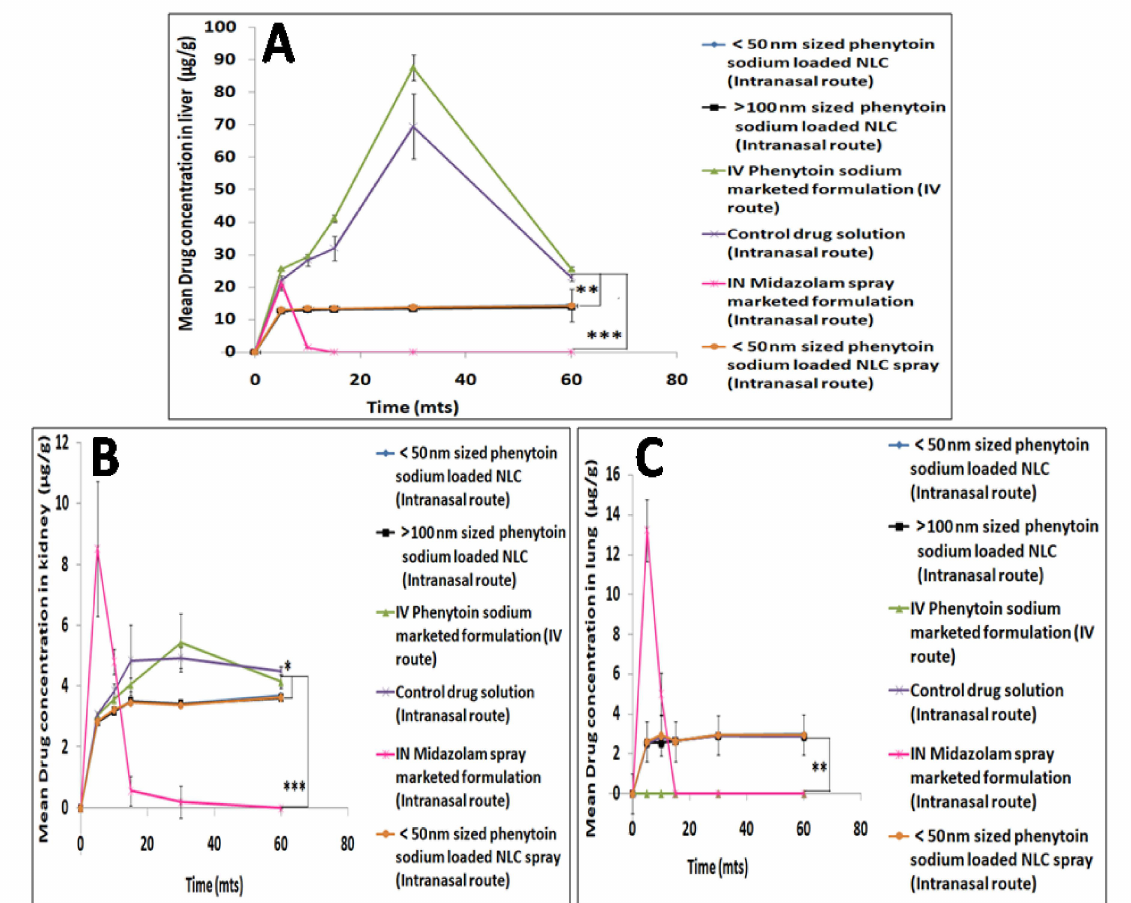
Figure 8. Mean liver ( A ), kidney ( B ) and lung ( C ) drug concentration profiles following intranasal administration of phenytoin sodium NLCs, control drug solution, midazolam spray marketed formulation and IV administration of phenytoin sodium marketed formulation. The level of statistical significance is expressed as a p -value; * indicates p < 0.05, ** indicates p < 0.01, *** indicates p <